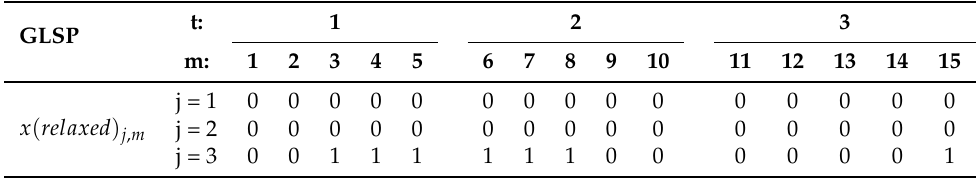
Table 6. Relaxed production sequence of the initial solution for the